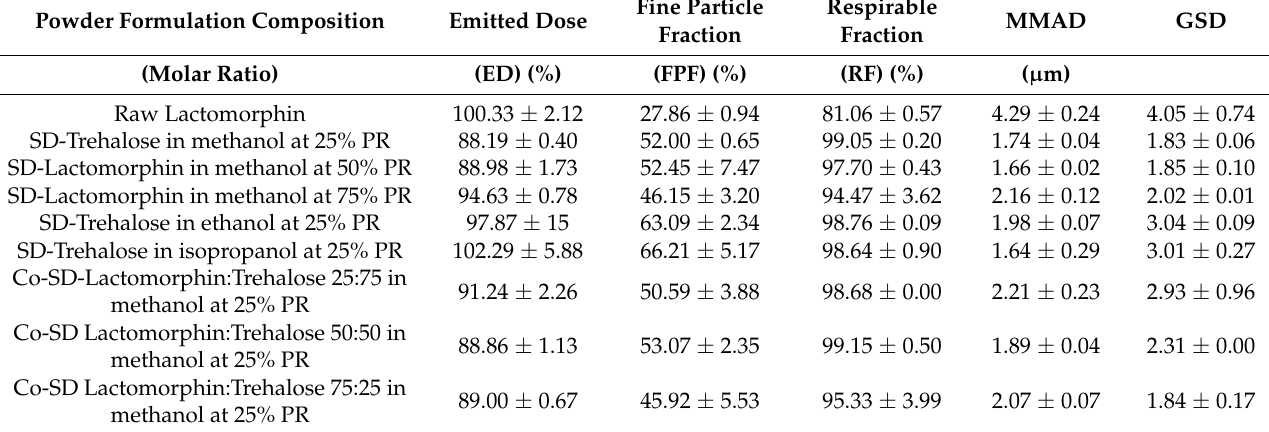
Figure 8. In vitro aerosol dispersion performance as DPIs using the NGI and the FDA-approved human DPI device, the Neohaler ® for: ( a ). Raw Lactomorphin, SD-Lactomorphin in methanol at different pump rates; ( b ). SD-Lactomorphin from different feed solvents at 25% PR; ( c ). Co-SD-Lactomorphin:Trehalose at different molar ratios in methanol at 25% PR. Table 5. Aerosol dispersion performance properties as aerosolized dry microparticulate/nanoparticulate powders in- cluding mass median aerodynamic diameter (MMAD), geometric standard deviation (GSD), fine particle fraction (FPF), respirable fraction (RF) and emitted dose (ED) for inhalable microparticle/nanoparticle formulations for inhalable micropar- ticle/nanoparticle formulations of raw Lactomorphin, SD-Lactomorphin, and co-Lactomorphin:Trehalose (mean ± standard deviation, n = 3).